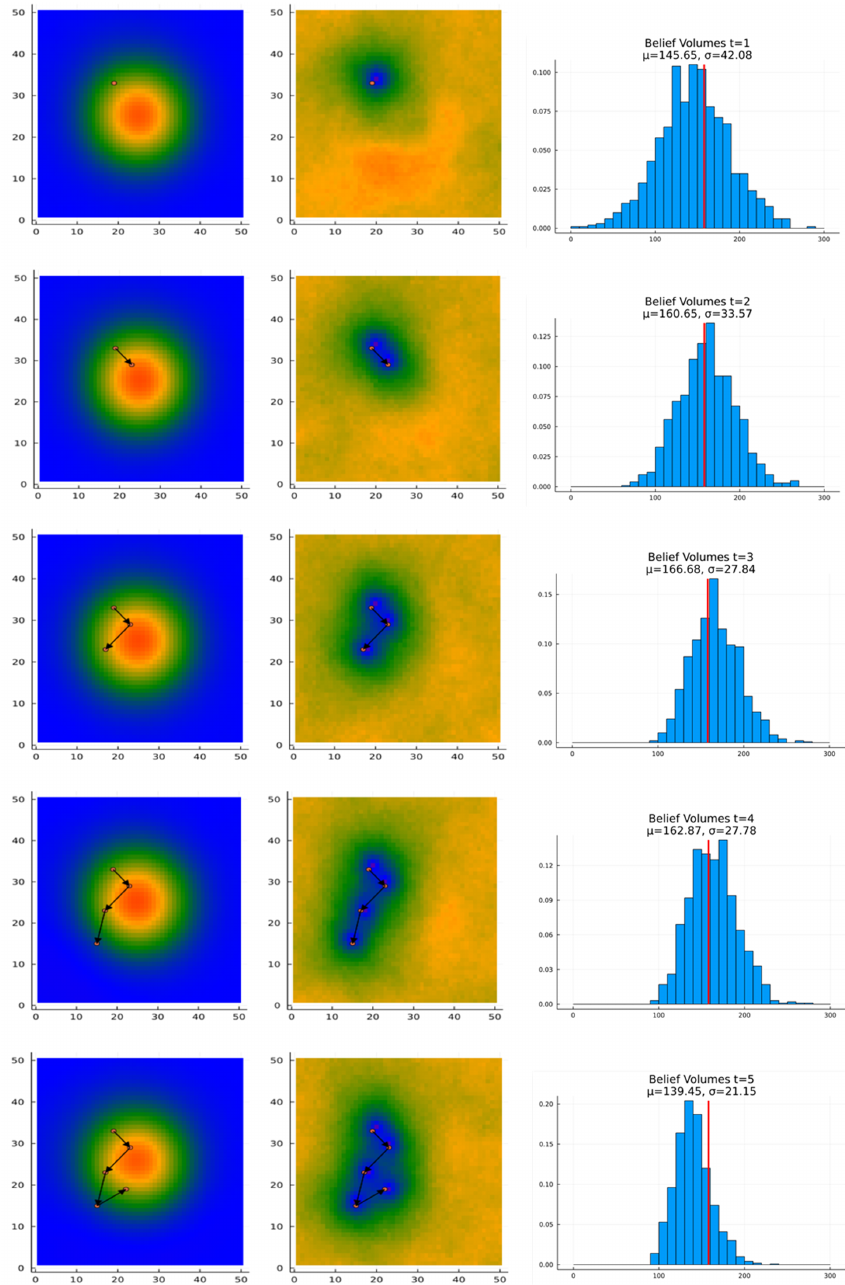
Figure 9. Initial measurement trajectory. Each panel shows the belief resulting from the measurements taken by the agent. The circles show the locations at which measurements were taken. The arrows indicate the sequence in which actions were taken.